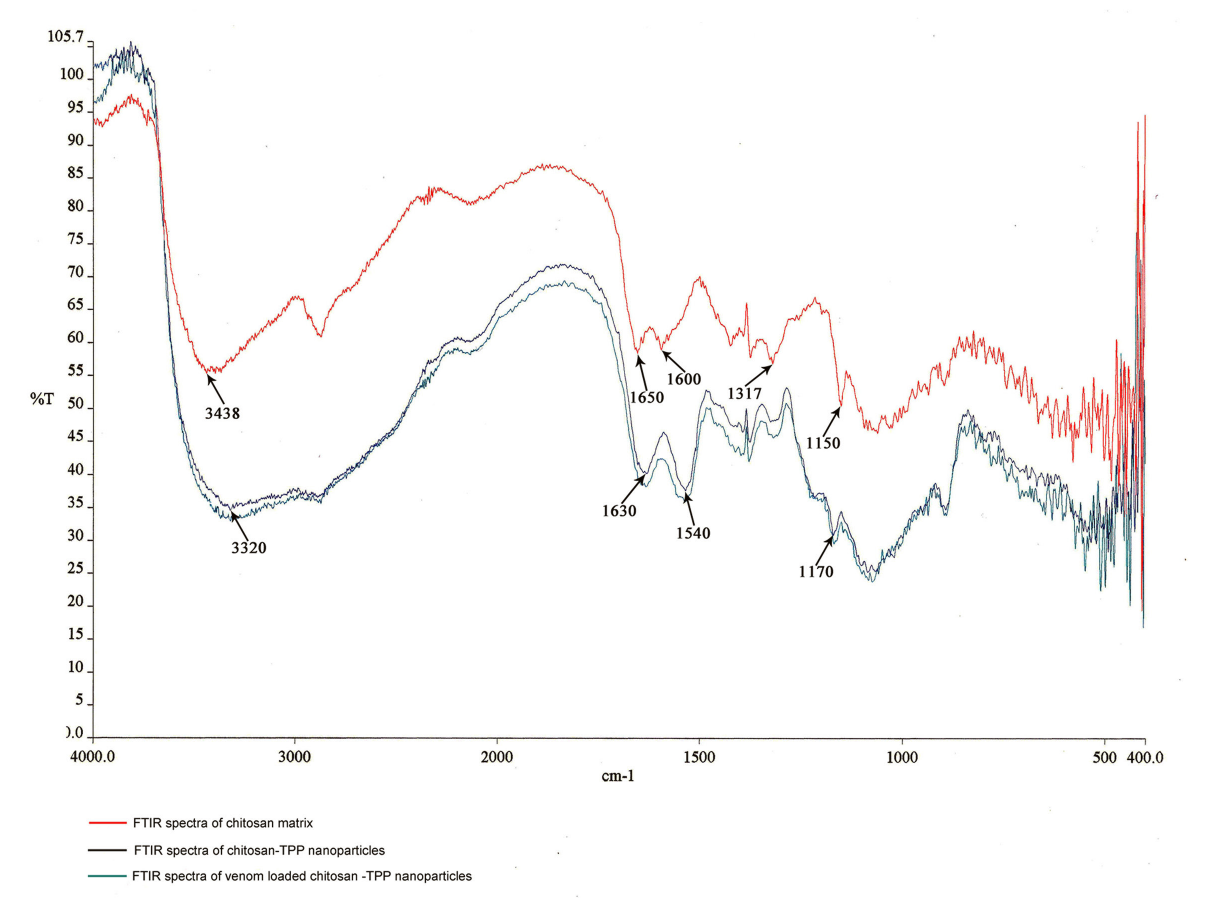
Figure 2. FTIR of chitosan, chitosan-TPP nanoparticles and M. eupeus venom-loaded chitosan-TPP